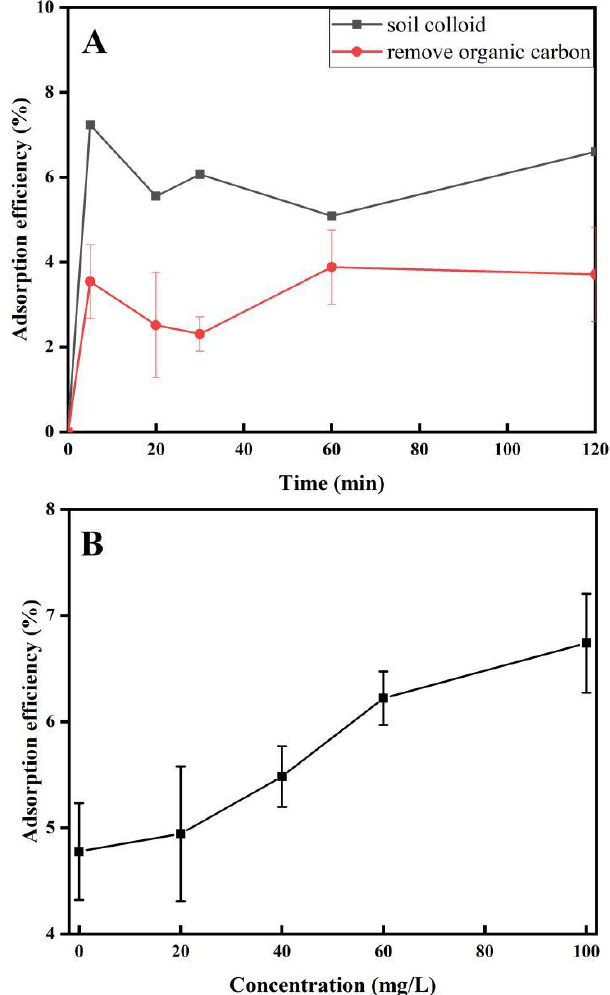
Figure 5. Effect of organic matter ( A ) and Effect of different concentration of HA ( B ) on the sorption of Sr on soil colloids. T = 25 ± 1 °C, soil-liquid rate = 0.8 g·L −1 , pH = 6 ± 0.1, C[Sr 2+ ] inital = 100 mg·L −1 .